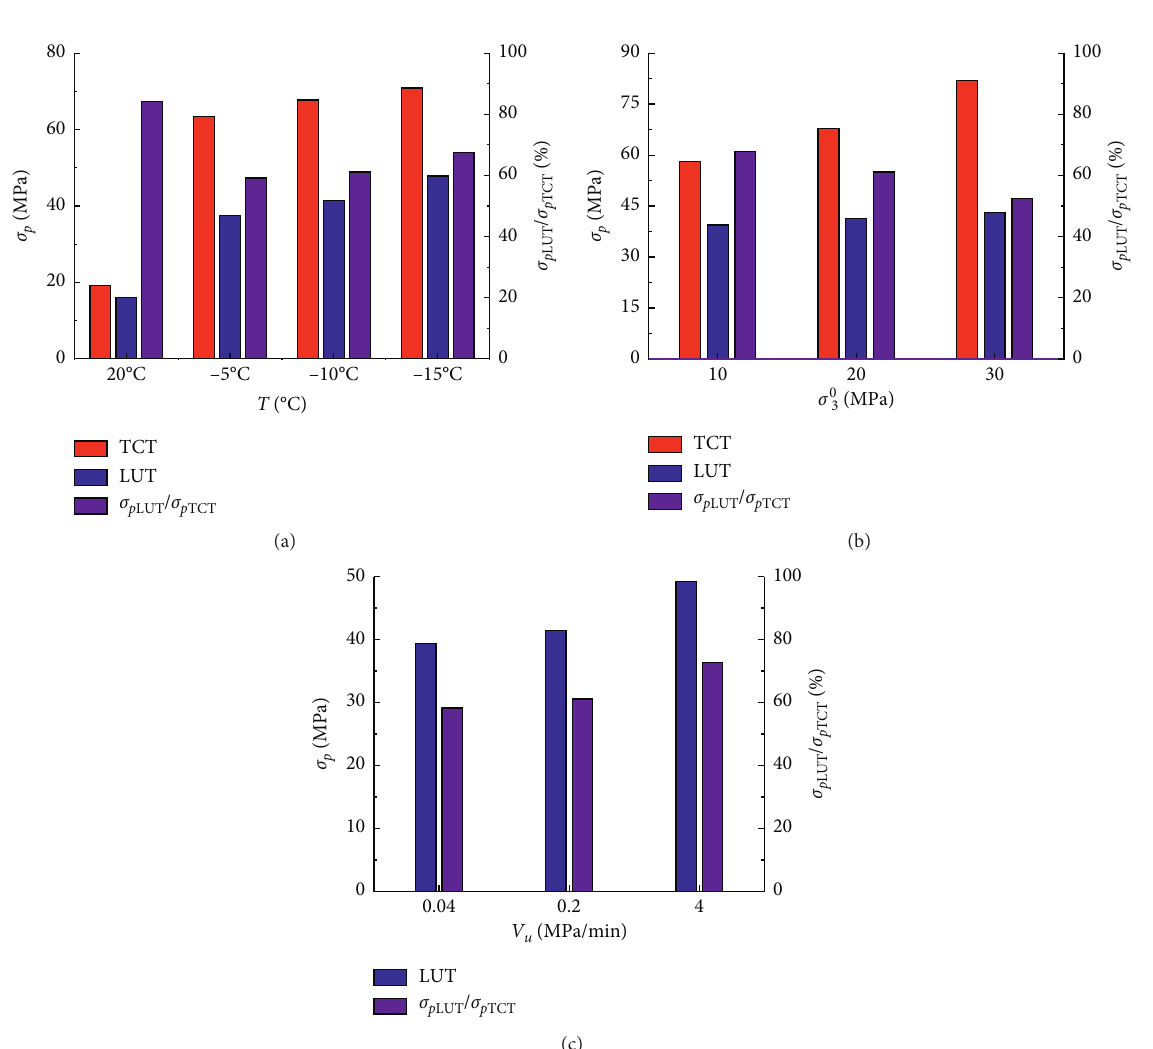
p : peak stress, σ p LUT / σ p TCT : ratio of the peak